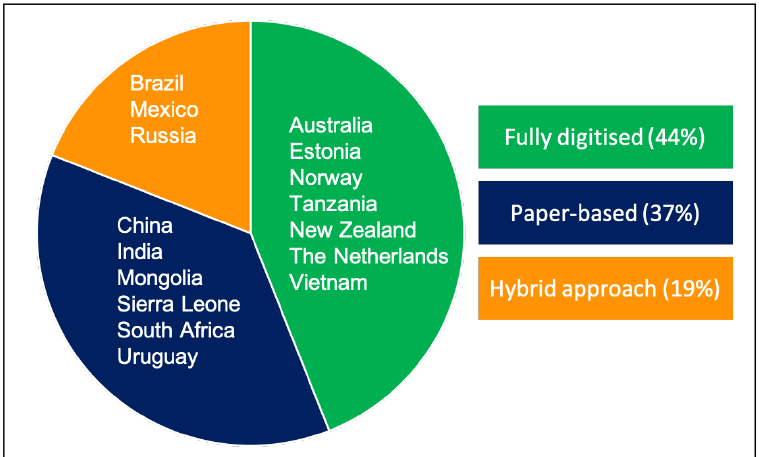
Figure 1: Vaccination record storage mechanisms across 16 investigated